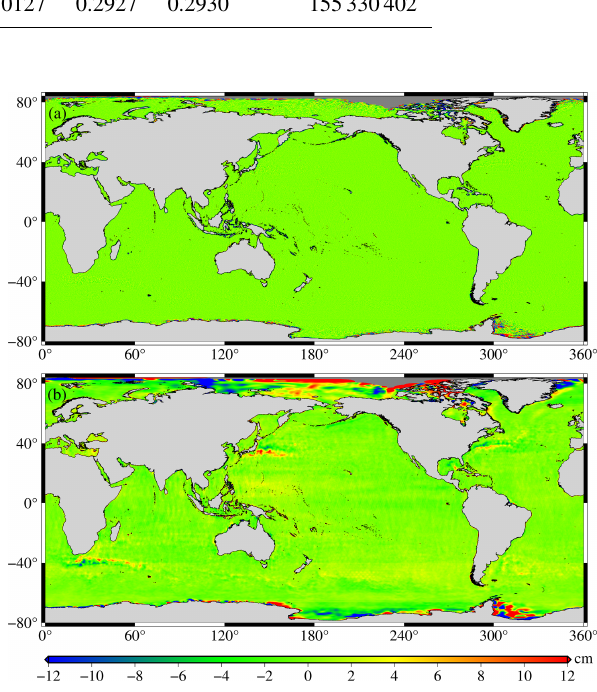
Figure 6. Differences between SDUST2020 and CLS15: (a) wave- length less than 150km and (b) wavelength greater than